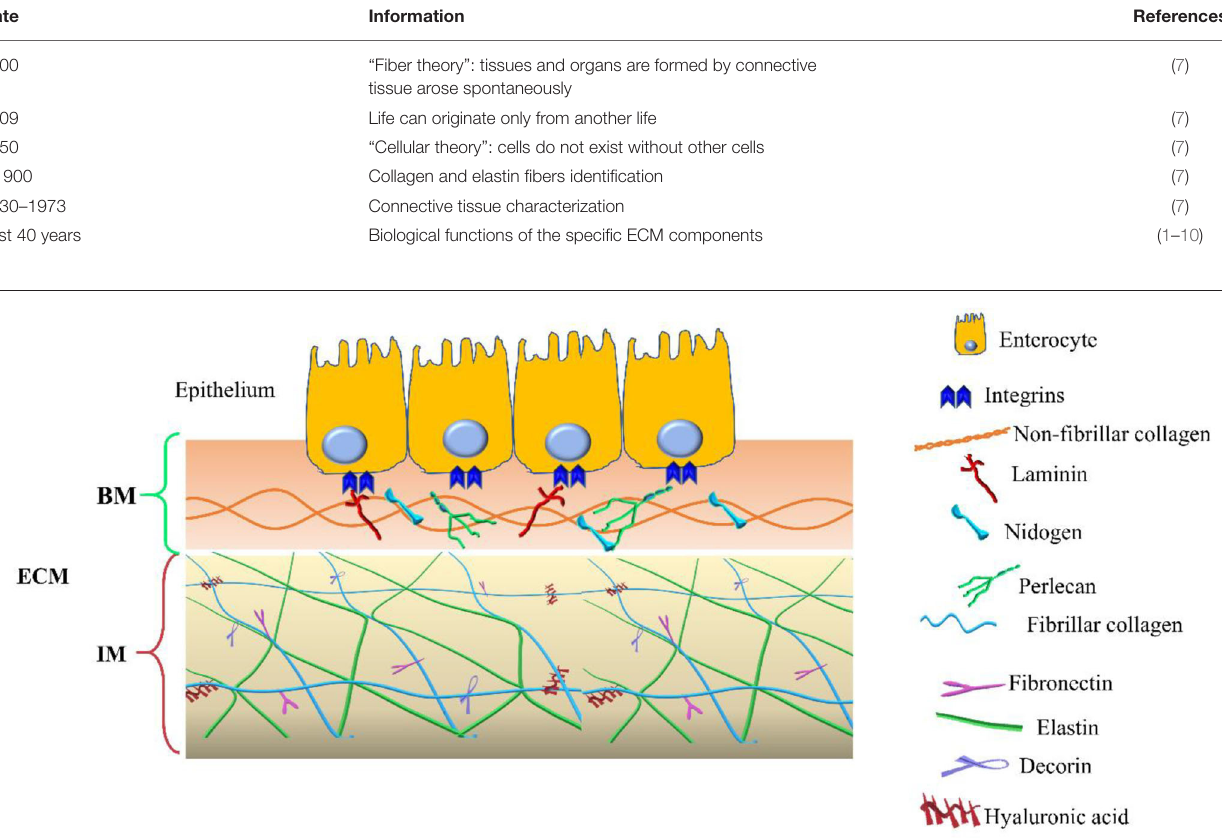
protein (HSPG) or heparan sulfate proteoglycan 2